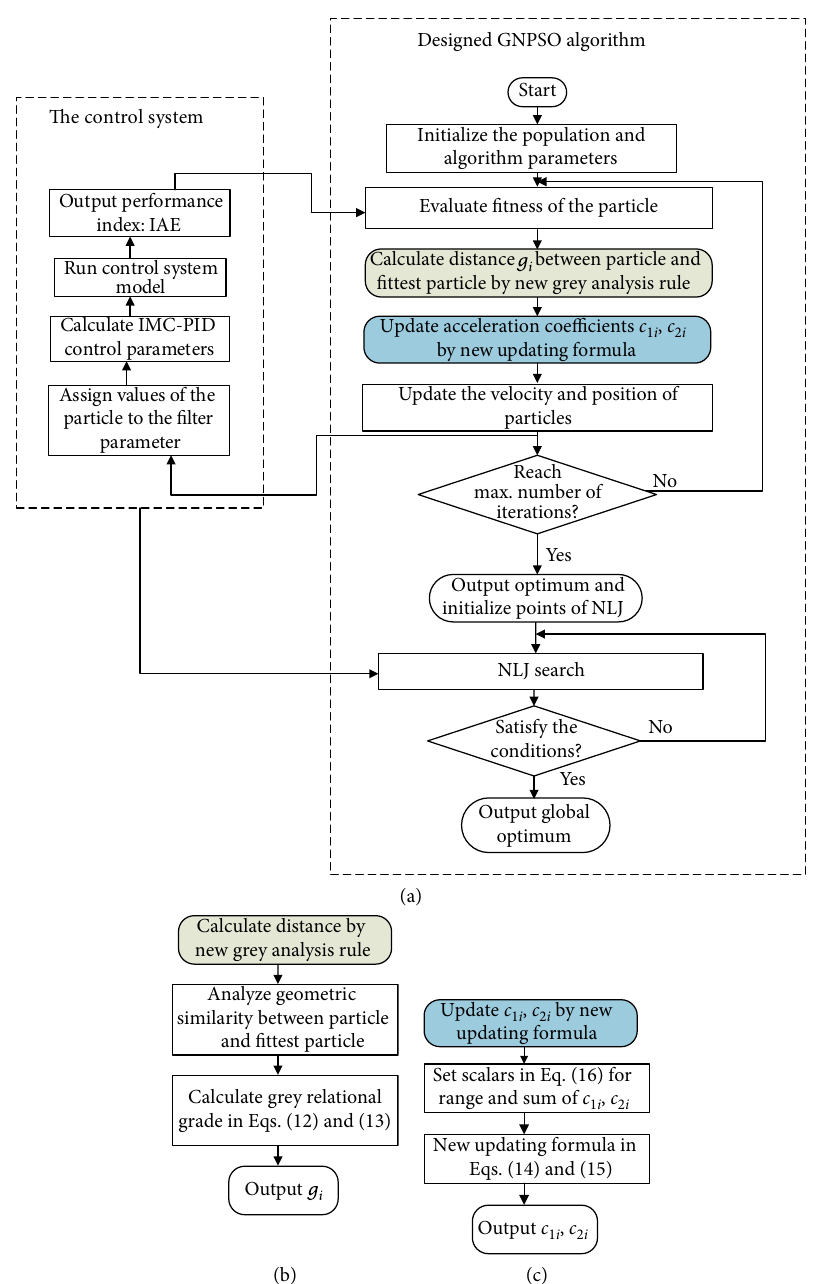
Figure 2: (a) Optimization procedure by proposed GNPSO algorithm. (b) Procedures of calculating distance by new grey analysis rule. (c) Procedures of updating acceleration